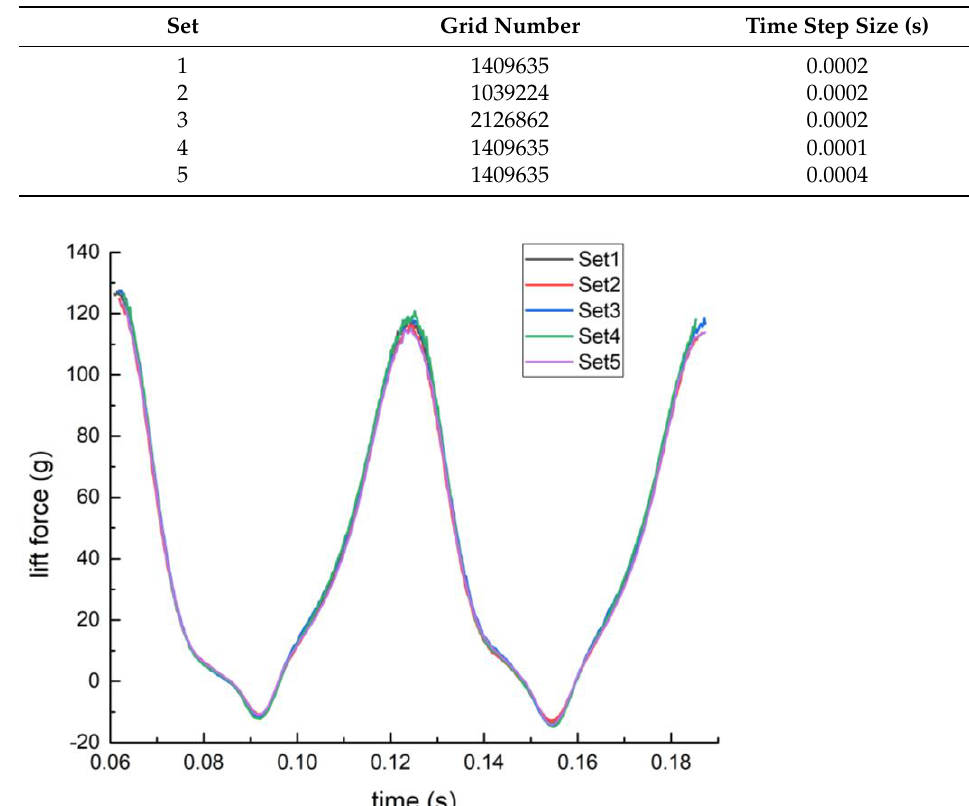
Table 1. The five different settings of the grid and time step independence test.